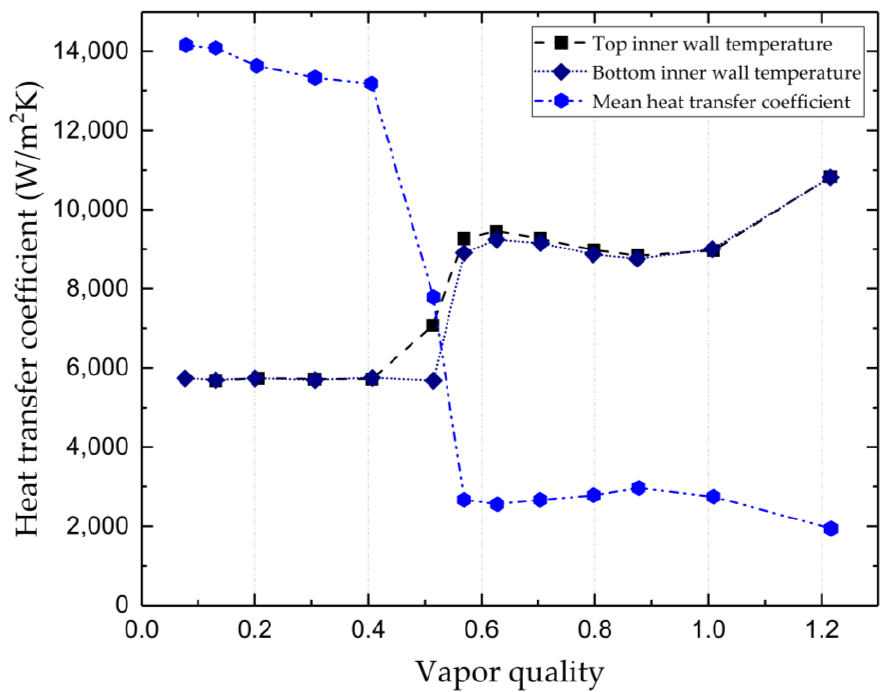
Figure 16. Mean HTCs and wall temperatures as a function of vapor quality at a T sat = 120 °C [84]